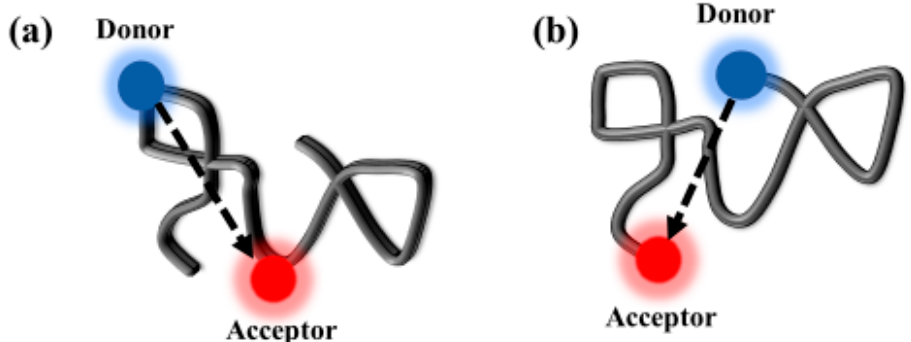
Figure 1. Schematic graphs for two types of intrachain fluorescence resonance energy transfer (FRET) methods classified by the varied fluorescent chromophores labeling strategies: ( a ) random labeling, where the donor and acceptor are randomly attached onto one single polymer chain; and ( b ) chain-end labeling, where the donor and acceptor are precisely fixed at chain terminals.